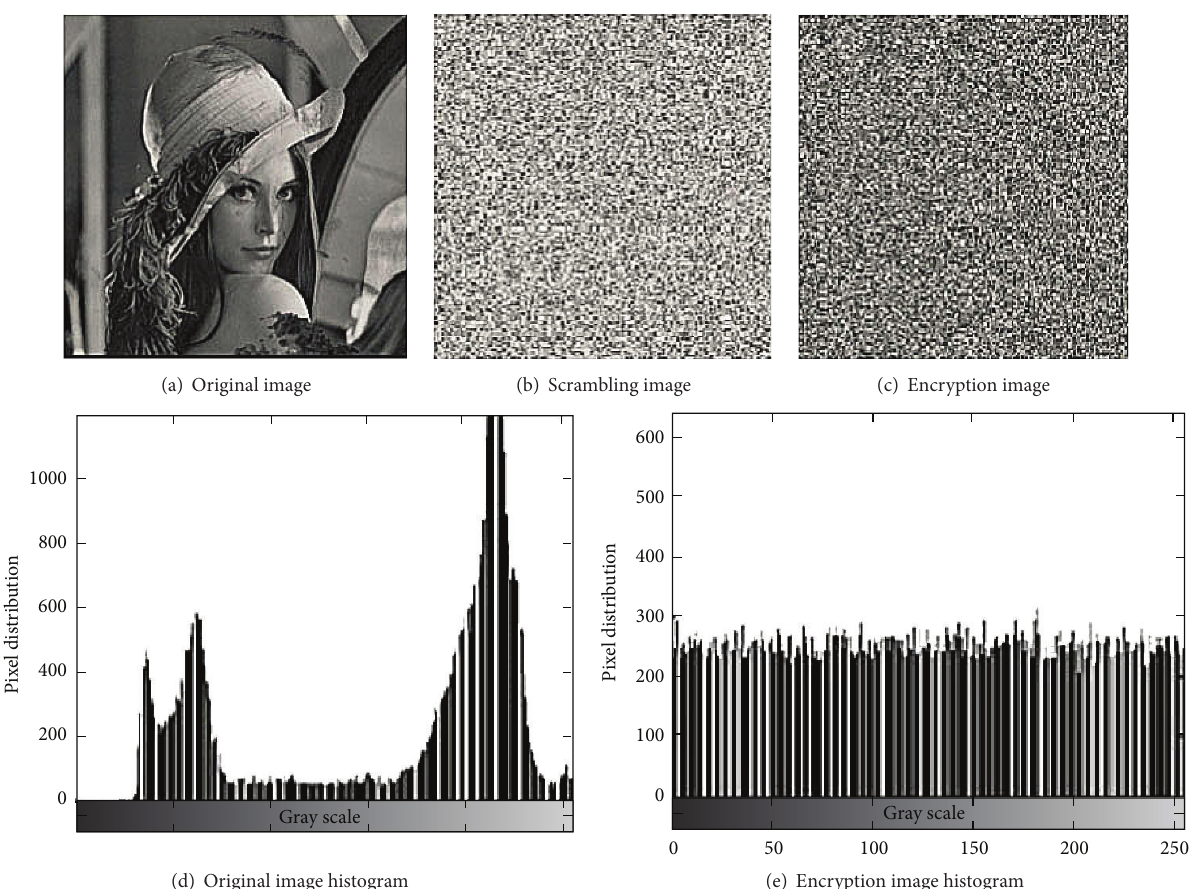
Figure 6: The original image and the encryption image histogram.